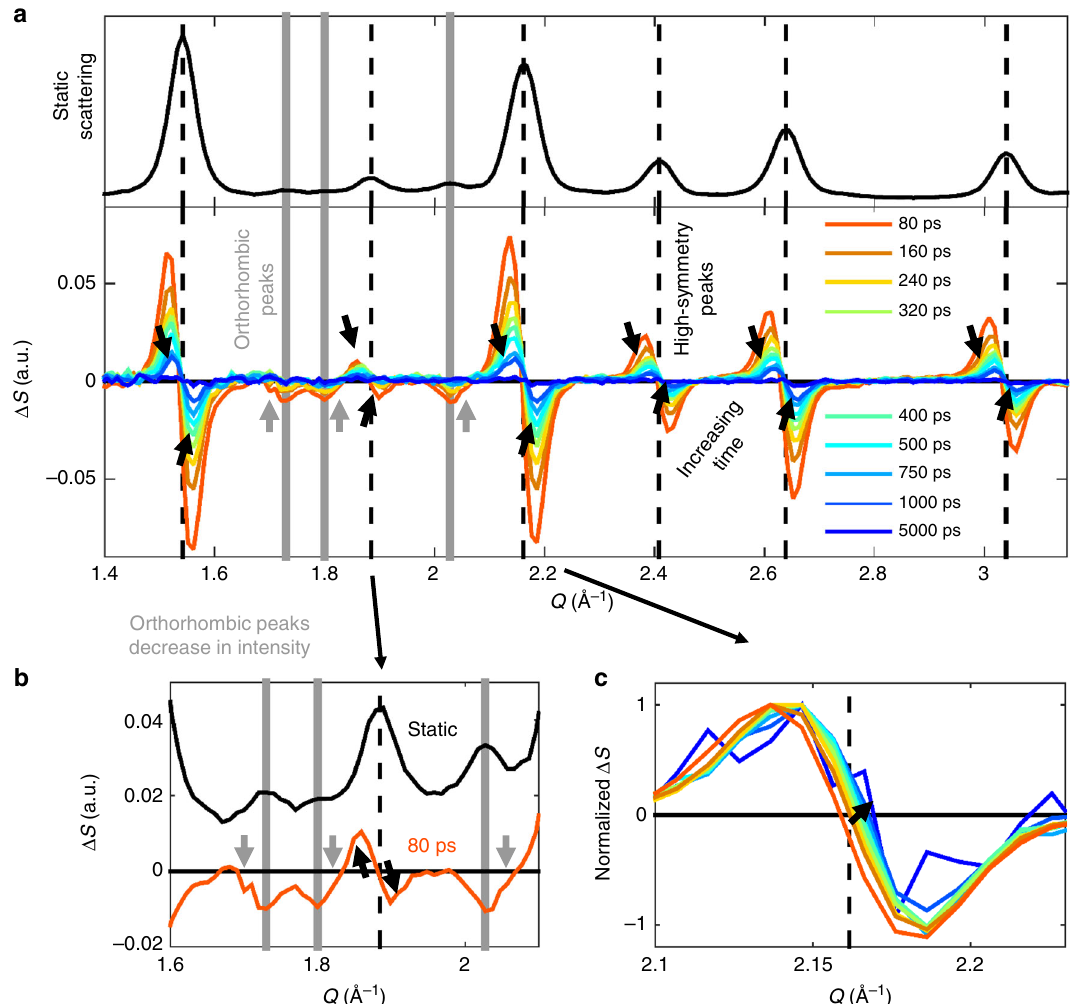
Fig. 2 CsPbBr 3 NC lattice response following moderate photoexcitation. a TR-XRD pattern of CsPbBr 3 NCs at various times following excitation at 4.8 mJ cm − 2 along with the static XRD pattern for reference on peak positions (black). The orthorhombic peaks are delineated with gray solid lines and the high- symmetry black dashed. A solid black line also denotes Δ S = 0 and arrows emphasize how the TR-XRD pattern evolves in time. b Zoomed in TR-XRD for 80 ps in the Q range of 1.6 – 2.1 Å − 1 . Once again, the static pattern is displayed with the same features marked as in a . Arrows emphasize how the TR-XRD pattern deviates from the static XRD. c TR-XRD pattern for the [200] peak normalized such that the maximum Δ S = 1. The arrow denotes how the pattern evolves in